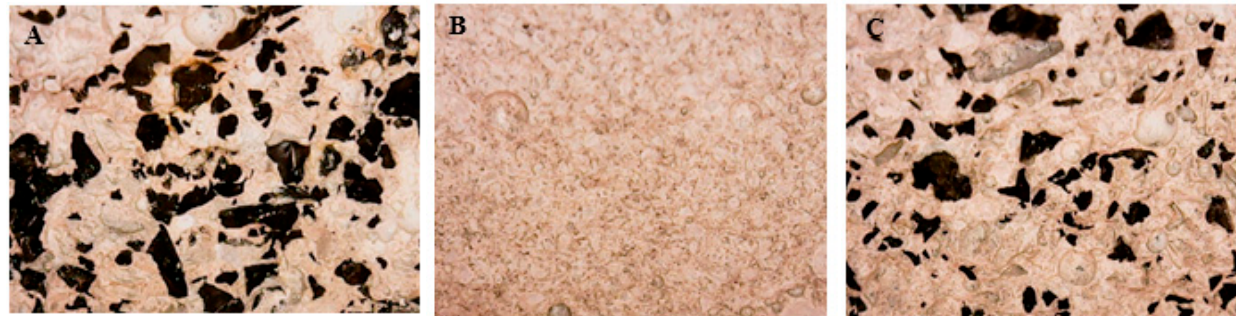
Figure 9. Sections of the ( A ) TR F sample (sample 1), ( B ) P sample (sample 10), ( C ) P/TR F sample (sample 11). The cross-section of these samples was analyzed by optical microscope after flexural rupture of the specimens.